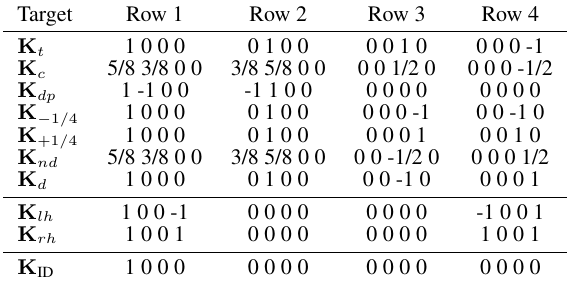
Table 1. Kennaugh Matrices for Elementary Targets and the Ideal